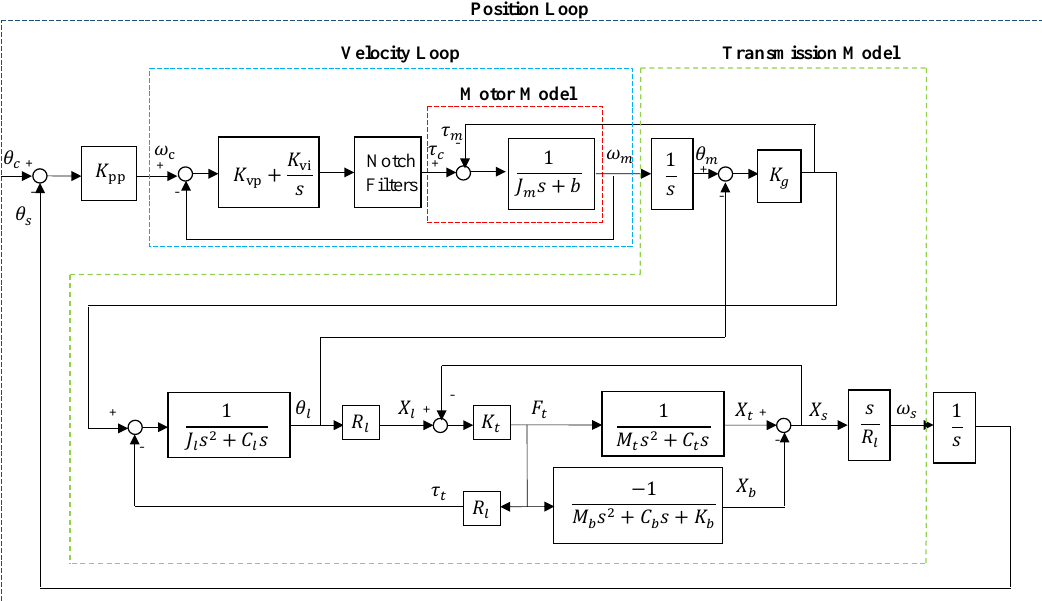
Figure 2. The block diagram of the servo feed drive system.